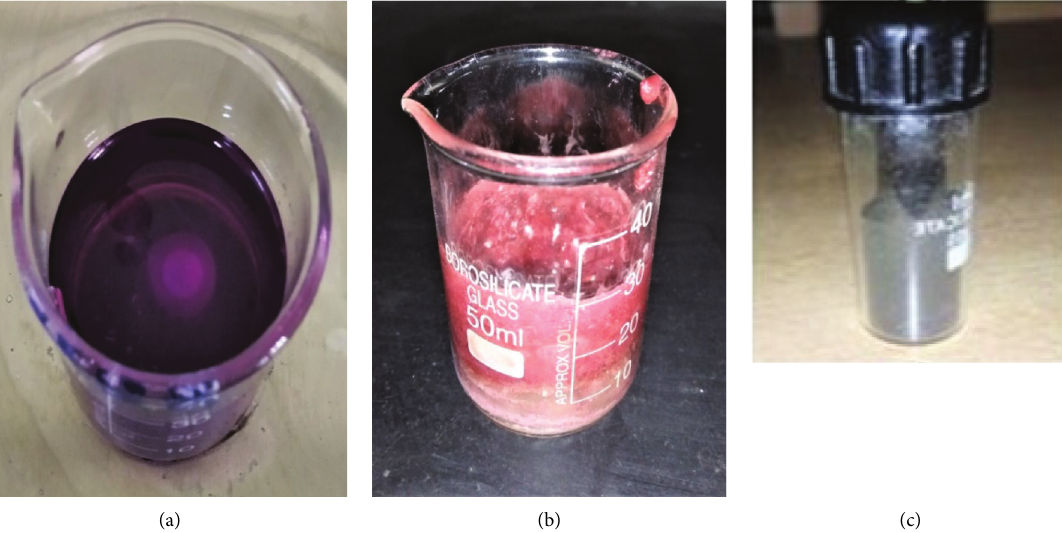
Figure 4: (a) Sol formation, (b) gel formation, and (c) perovskite.